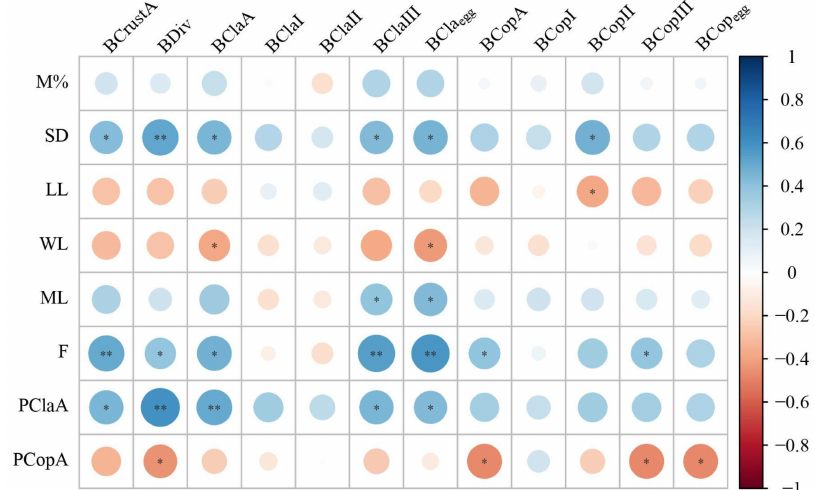
Figure 6. Spearman correlations ( p < 0.05) among planktonic crustaceans in sediment and abiotic and biotic parameters. Prefix B indicated traits in benthal, prefix p indicated traits in plankton. Significance codes are as follows: p < 0.01 ‘**’ and p < 0.5 ‘*’. Other abbreviations are given in